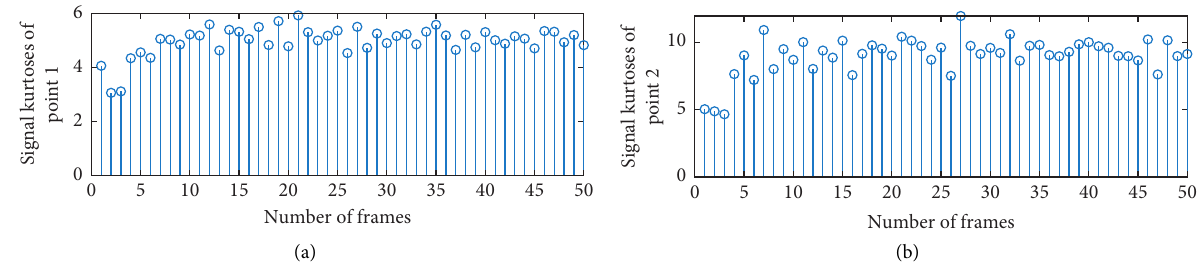
Figure 25: Kurtoses of the initial 50 frames of the response